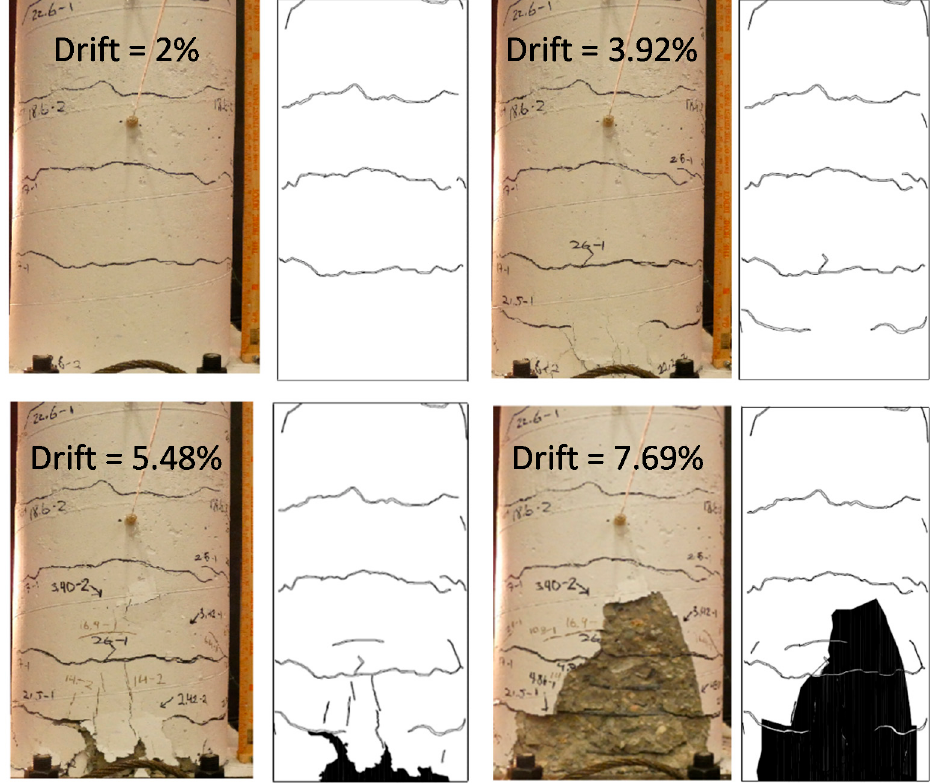
Figure 8. Crack maps at four different column drifts.